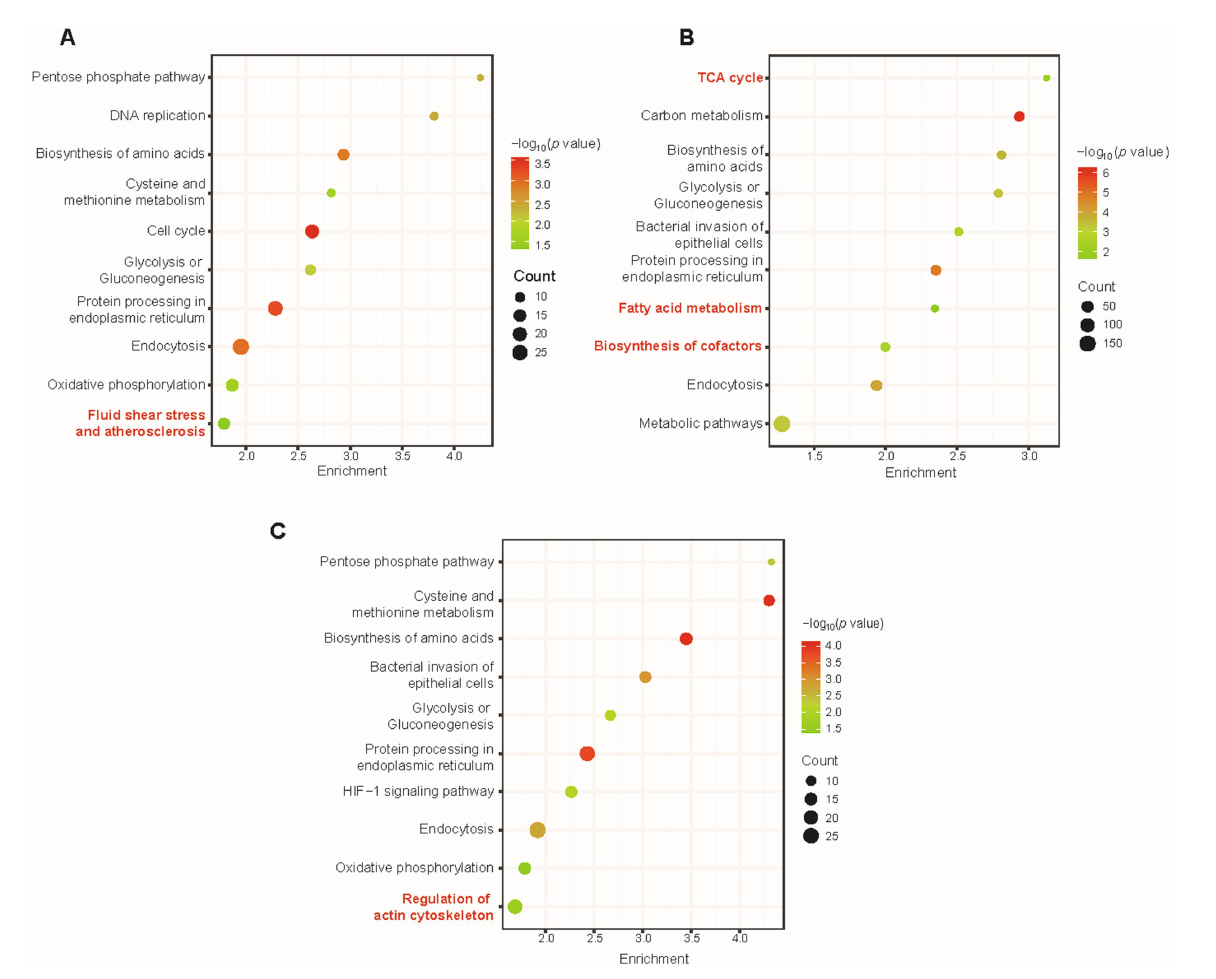
FIGURE 4 The overall KEGG pathway enrichment during VACV-induced cell migration at multiple time points of infection. Pathway enrichment of dysregulated proteins at 12 h.p.i. (A) , 24 h.p.i. (B) , and 36 h.p.i. (C) . Gradient color represents p value, and the size of circles represents protein counts in each pathway. Significant terms are marked in